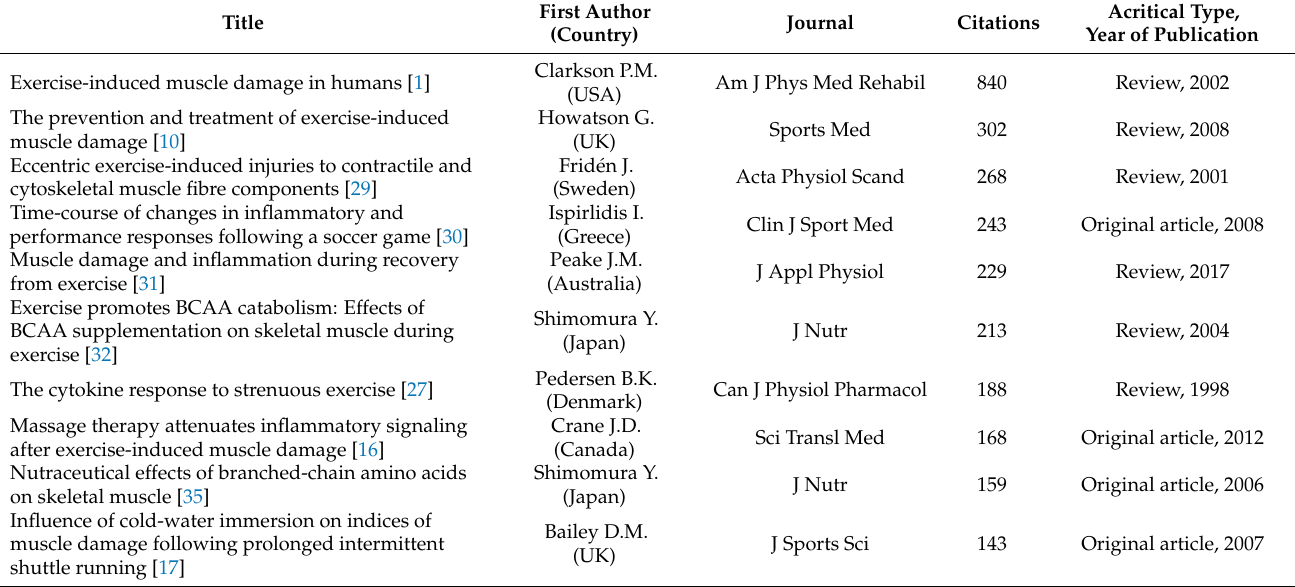
Table 2. The top ten EIMD and protein intake studies with the most citations.